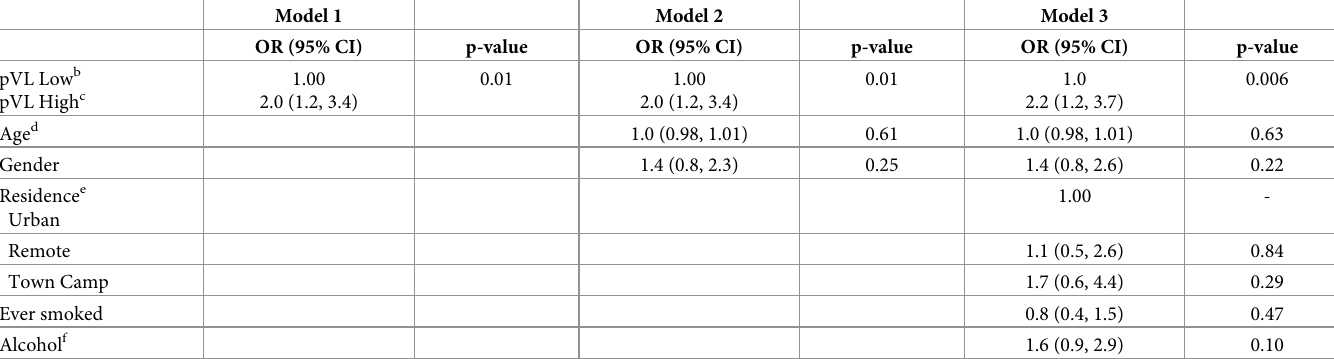
Table 4. Multivariable predictors of bronchiectasis a among HTLV-1 infected subjects 1 (n =